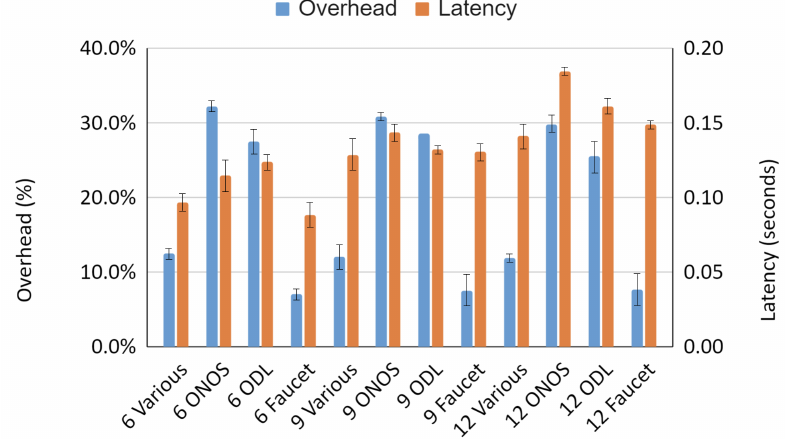
Figure 6. Latency and Overhead